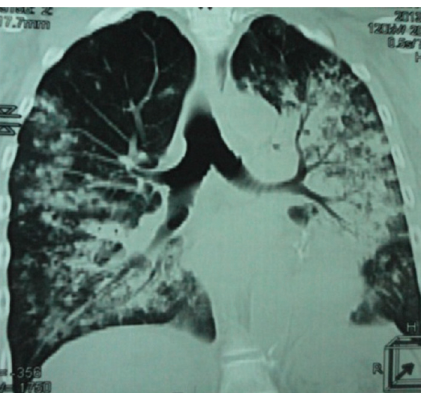
Figure 3: Chest CT: bilateral alveolar infiltrates in a ground-glass